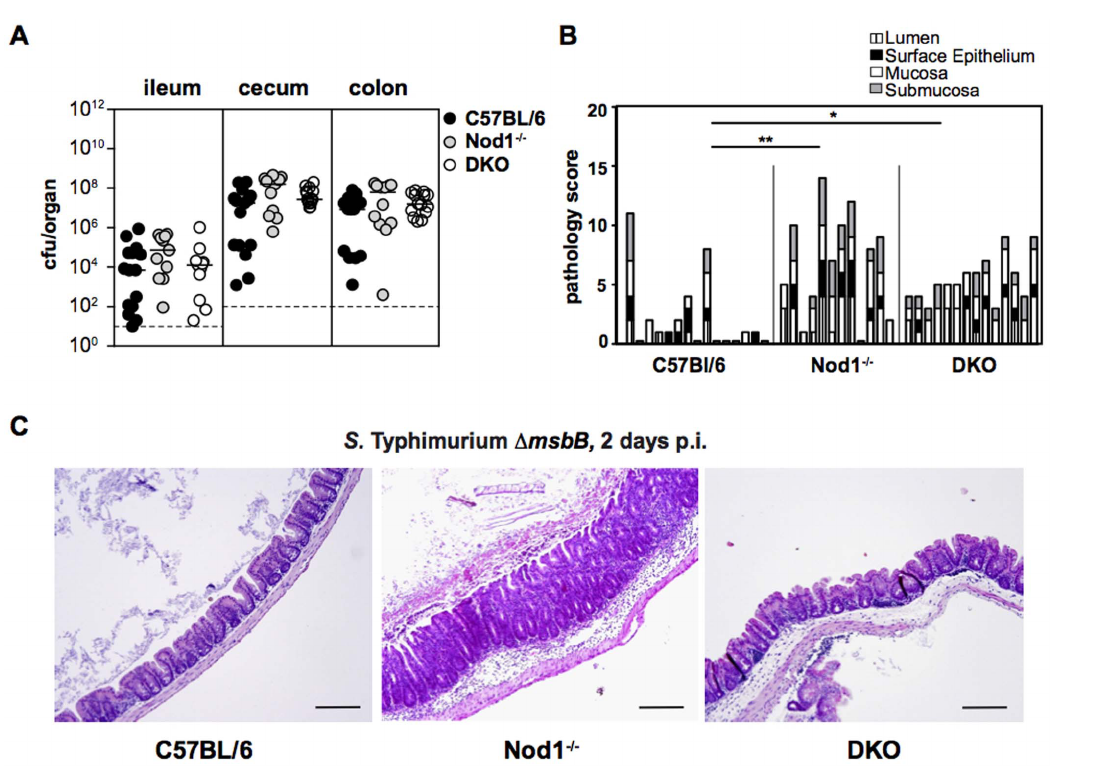
Figure 5. Nod1 also dampens S. Typhimurium D msbB -induced colitis. Streptomycin-pretreated C57Bl/6, Nod1 2 / 2 and DKO mice were orally infected with S. Typhimurium D msbB for 2 days. (A) S. Typhimurium colonization of ileum, cecum and colon. Dashed line: limit of detection; cfu: colony forming units. (B) Pathology scores of infected ceca. Statistical analysis: 1way ANOVA with Bonferroni’s multiple comparison post-test. * p , 0.05; ** p , 0.01. (C) H&E staining of infected cecum sections. Original magnification 200 6 ; scale bars 5 100 m m.